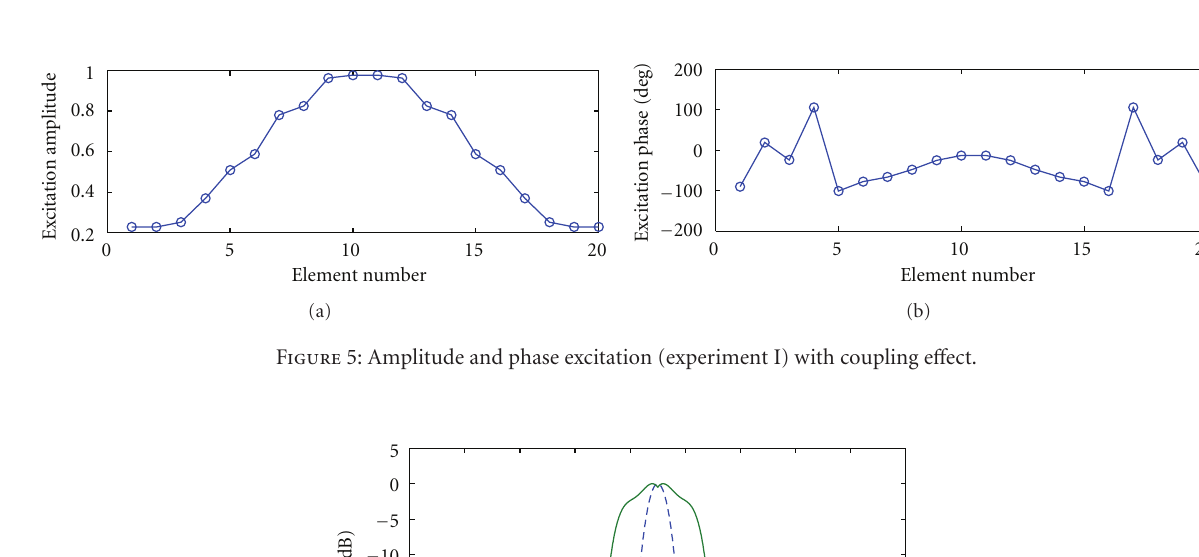
Figure 4: Amplitude and phase excitation (experiment II).